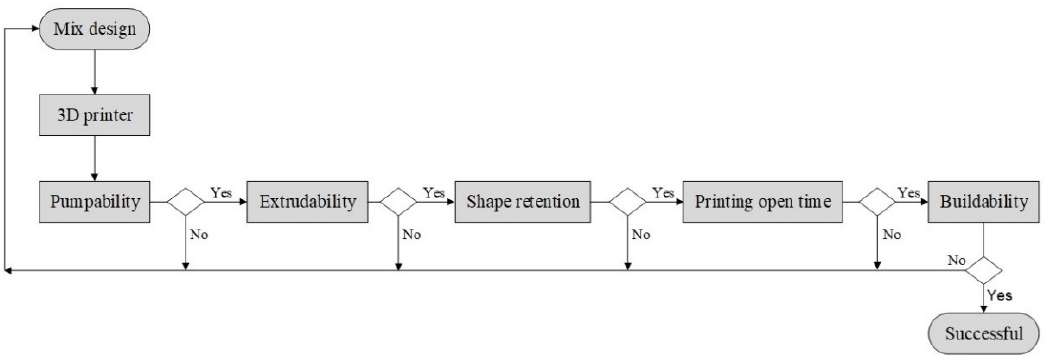
Figure 4. An illustrative comparison of percentage of materials (by volume) used in conventional concrete, self-compacting concrete, and 3D-printable concrete.